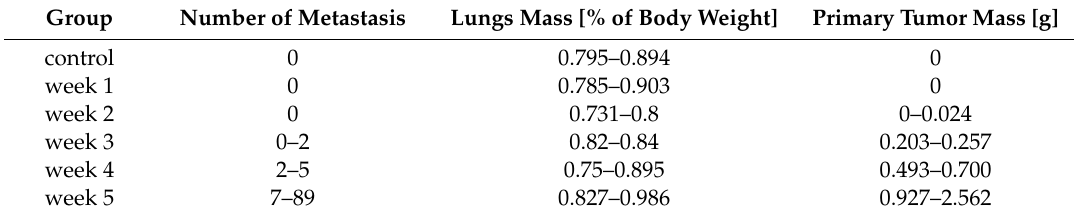
Table 1. The number of metastases, lung weight expressed as a percentage of body weight, and primary tumor mass in the 4T1 metastatic breast cancer model ( N = 3 animals per experimental